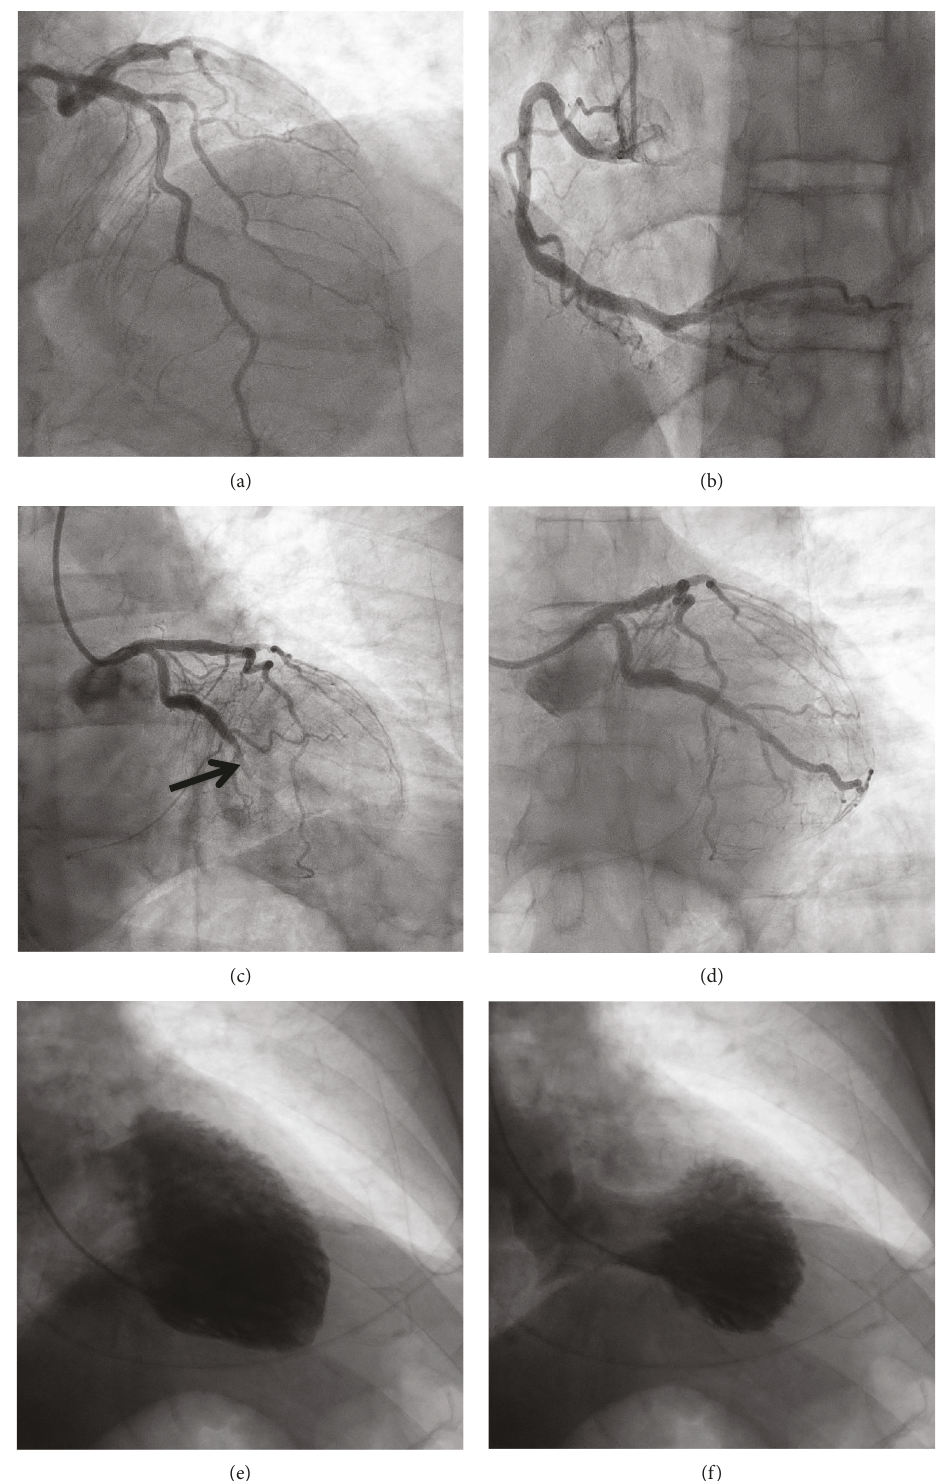
Figure 2: Coronary angiography on admission. (a) Minor disease in the left anterior descending artery. (b) Mild-moderate disease in the right coronary artery. (c) Occluded OM2 branch (arrow) of the left circum fl ex artery. (d) TIMI III fl ow post percutaneous coronary intervention (PCI) with drug-eluting stent (DES). Left ventriculogram in the right anterior oblique (RAO) projection during diastole (e) and systole (f) showing mid apical pattern of takotsubo syndrome with sparing of the apical